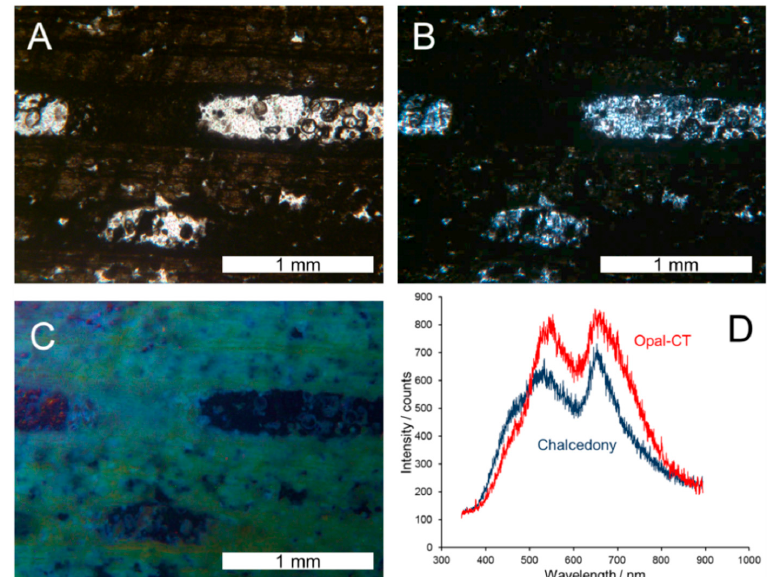
Figure 16. Photomicrographs of chalcedony-mineralized early wood vessels surrounded by opalized tissue (tangential plane). ( A ) Transmitted light OM imge; ( B ) Cross-polarized light OM image; ( C ) panchromatic OM-CL image; ( D ) CL spectra taken form opal/chalcedony rich regions.